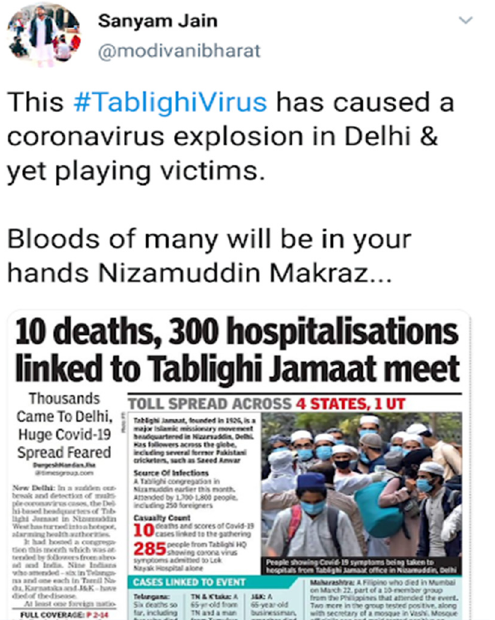
Figure 18. Meme shared by Hindu nationalist supporters promoting idea of “corona jihad”.